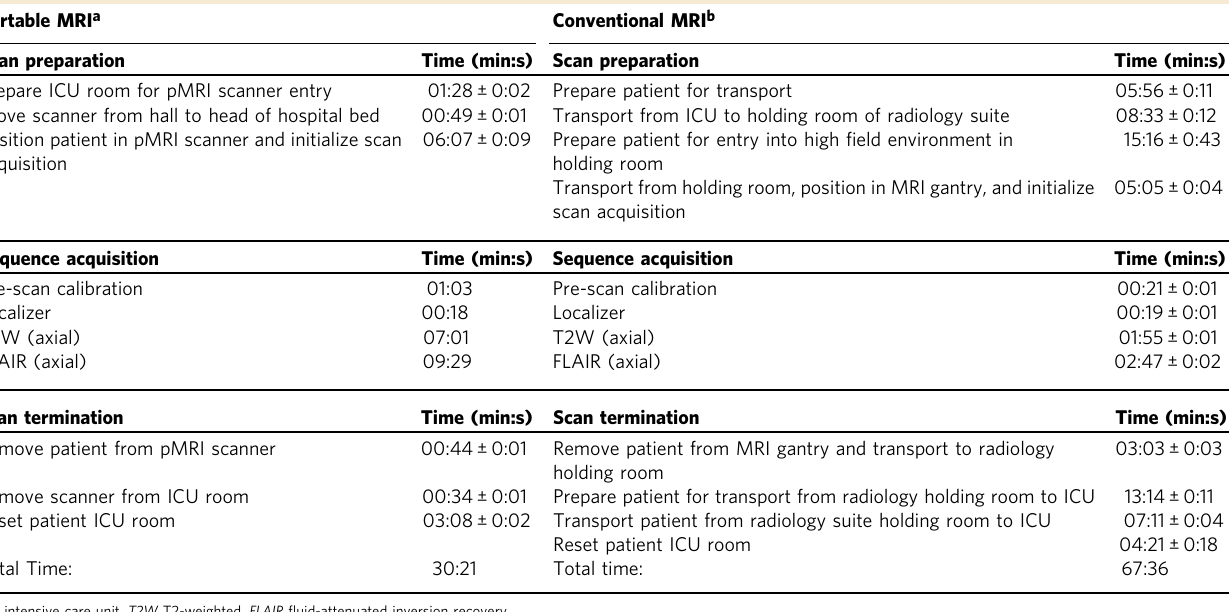
Table 2 Portable MRI examination time compared to conventional MRI. Portable MRI a Conventional MRI